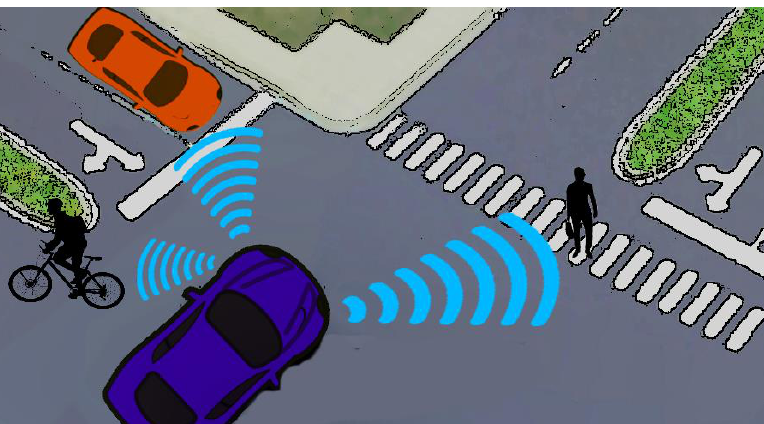
Figure 10. Autonomous vehicle in city driving.